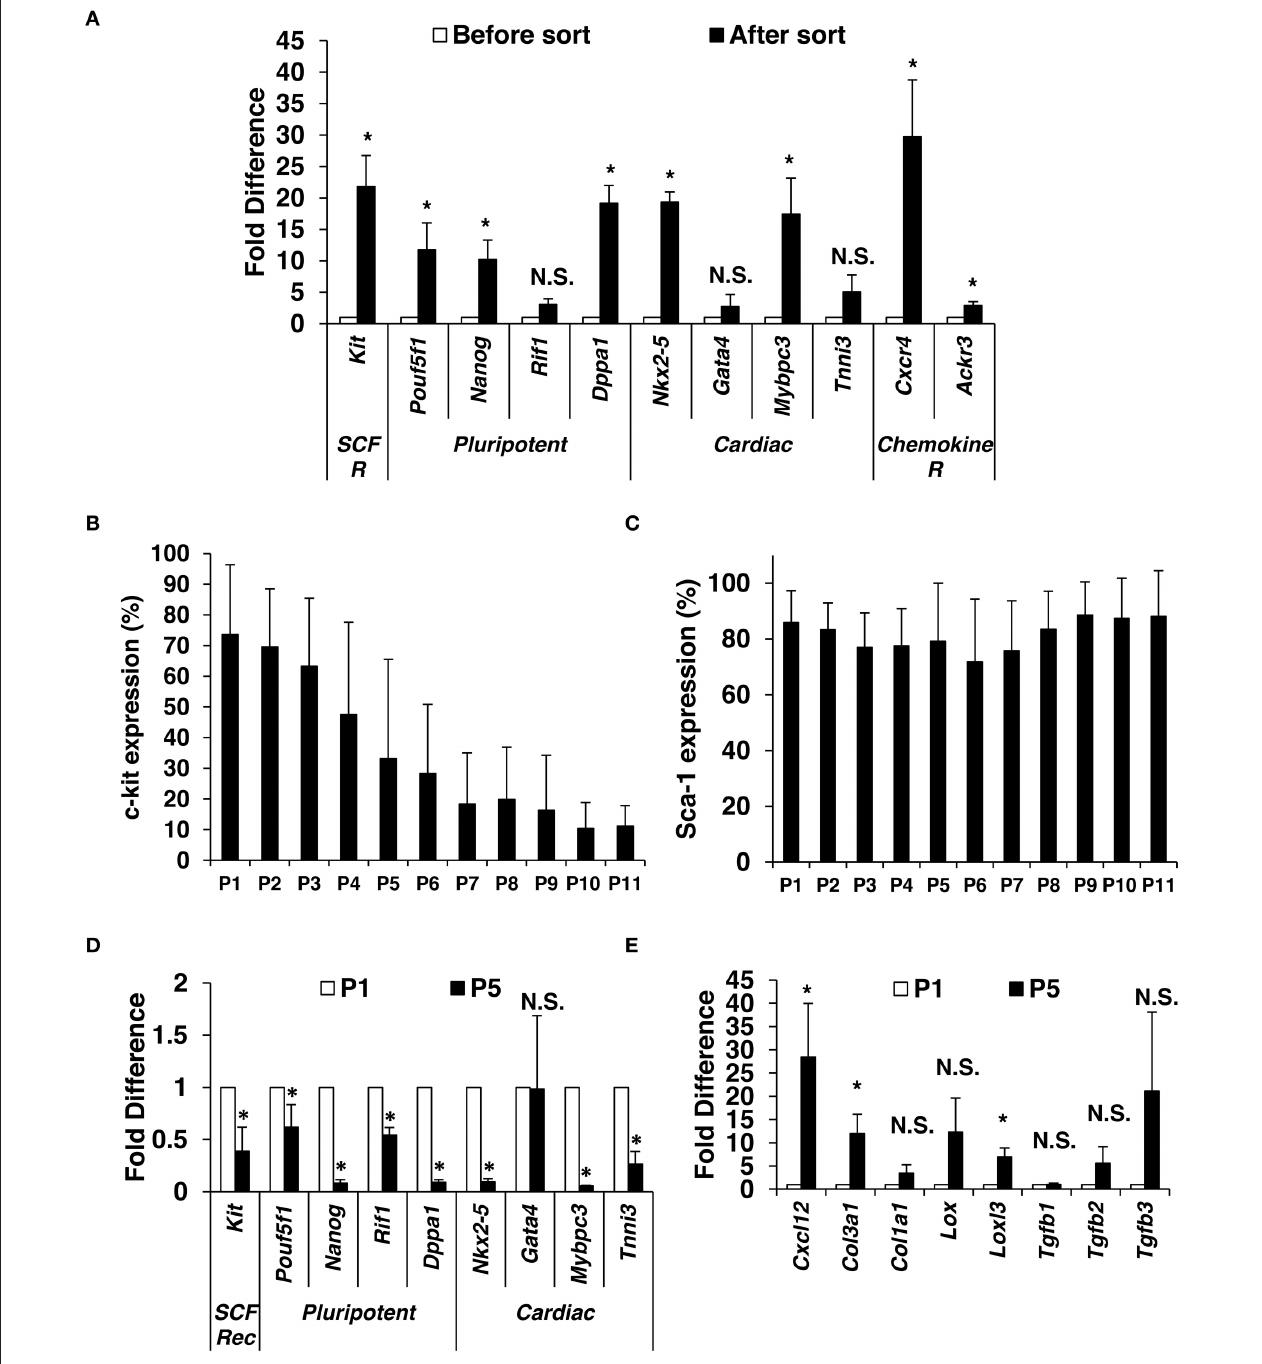
FIGURE 1 | Isolation and characterization of mouse c-kit pos CMCs. Enzymatically dissociated mouse hearts were left in culture medium for 24h. When reached 70% confluence (4–6 days of expansion), c-kit positive CMCs were positively selected using magnetic beads. (A) Immediately after sorting, qPCR was performed to compare gene expression for c-kit, pluripotency markers, cardiac markers, and chemokine receptors ( n = 5). C-kit (B) and Sca-1 (C) were monitored by flow cytometry up to 11 passages after sort ( n = 13). Gene expression comparison in c-kit pos CMCs between passage 1 and 5 ( n = 4) (D,E). Values are mean ± SD * p < 0.05 vs.